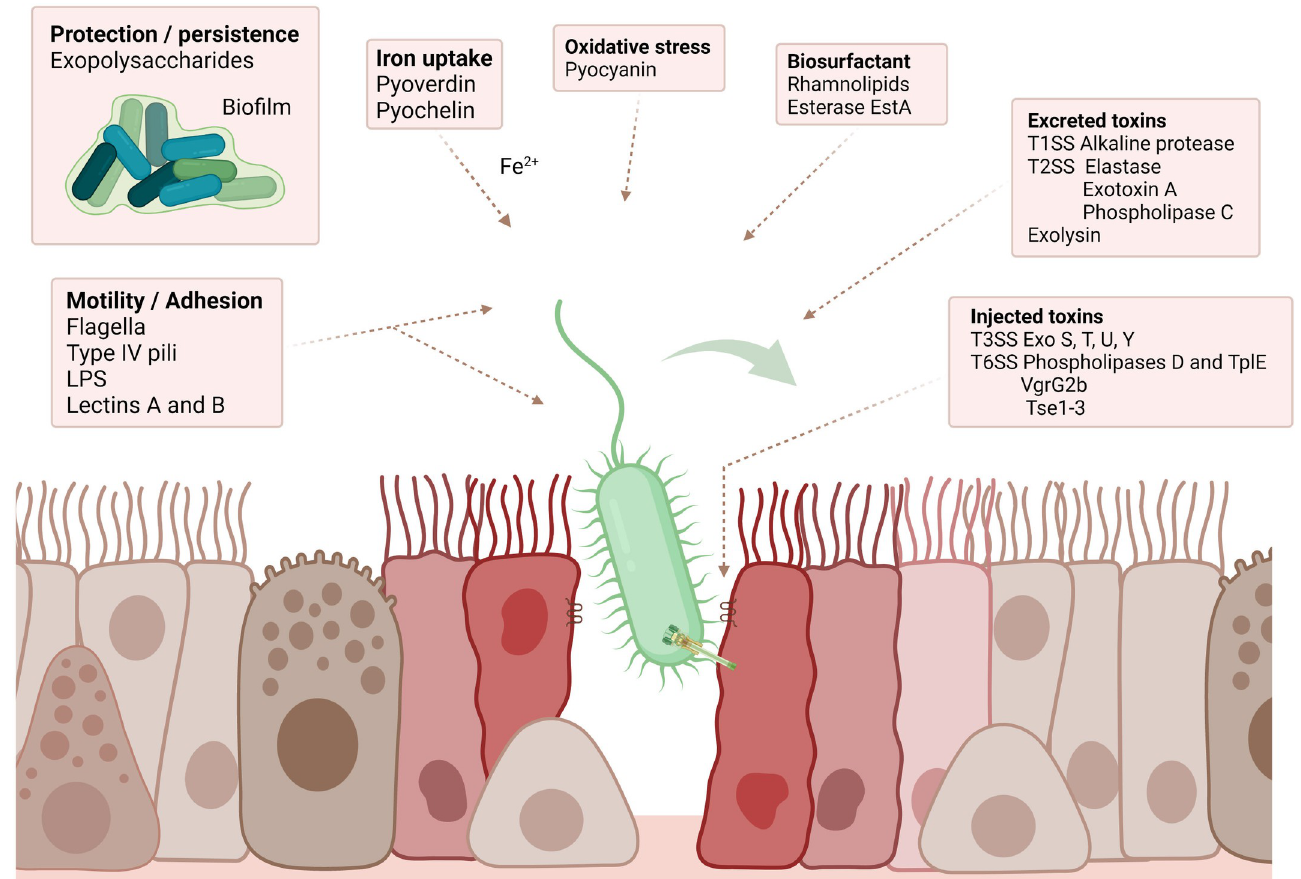
Fig 4. aeruginosa main virulence factors in respiratory infections. P . Created with BioRender.com.